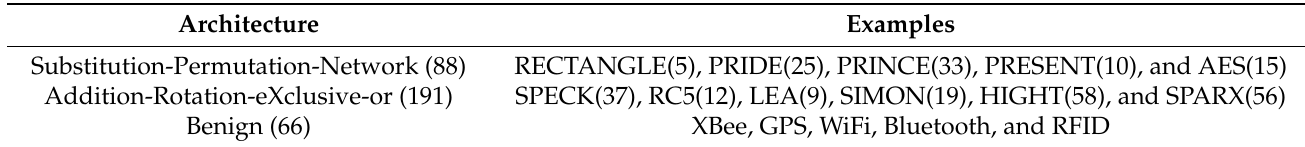
Table 3. Detailed programs for the dataset.